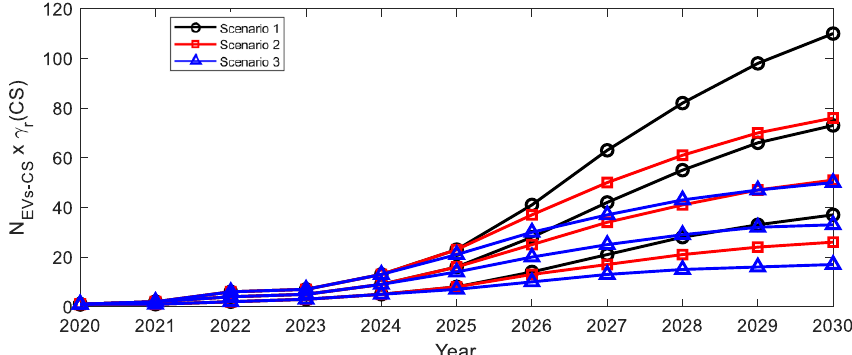
Figure 17. Number EVs potential users of the project’s charging station, combined with γ c ( PFS ) scenarios.